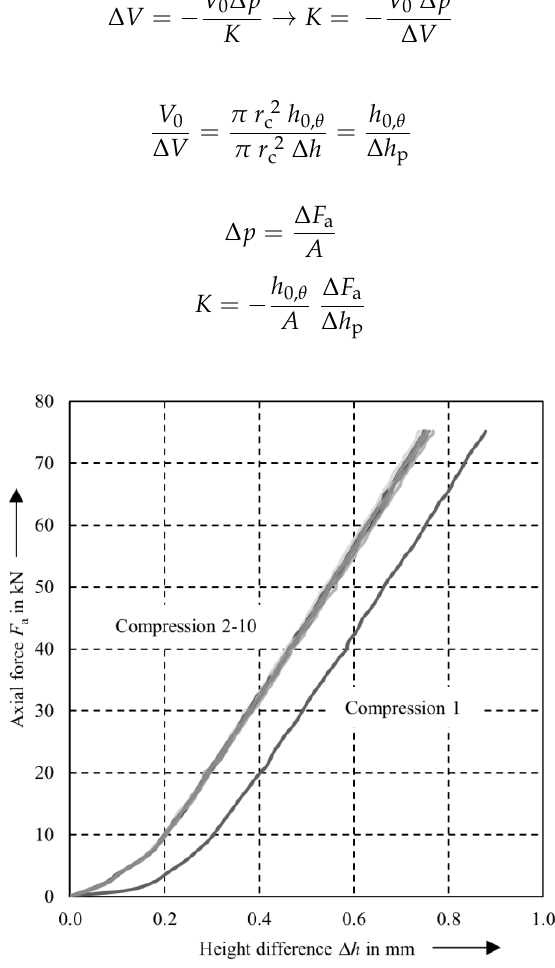
Figure 4. Experimental data for the compression module θ t = 65 °C.